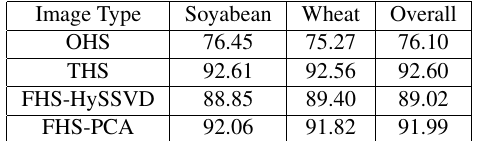
Table 3: Classification Performance on mixed pixels for different image types